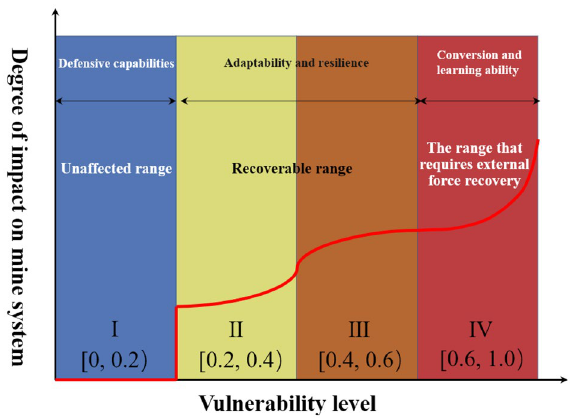
Figure 4. Vulnerability classification model for non-coal underground mine